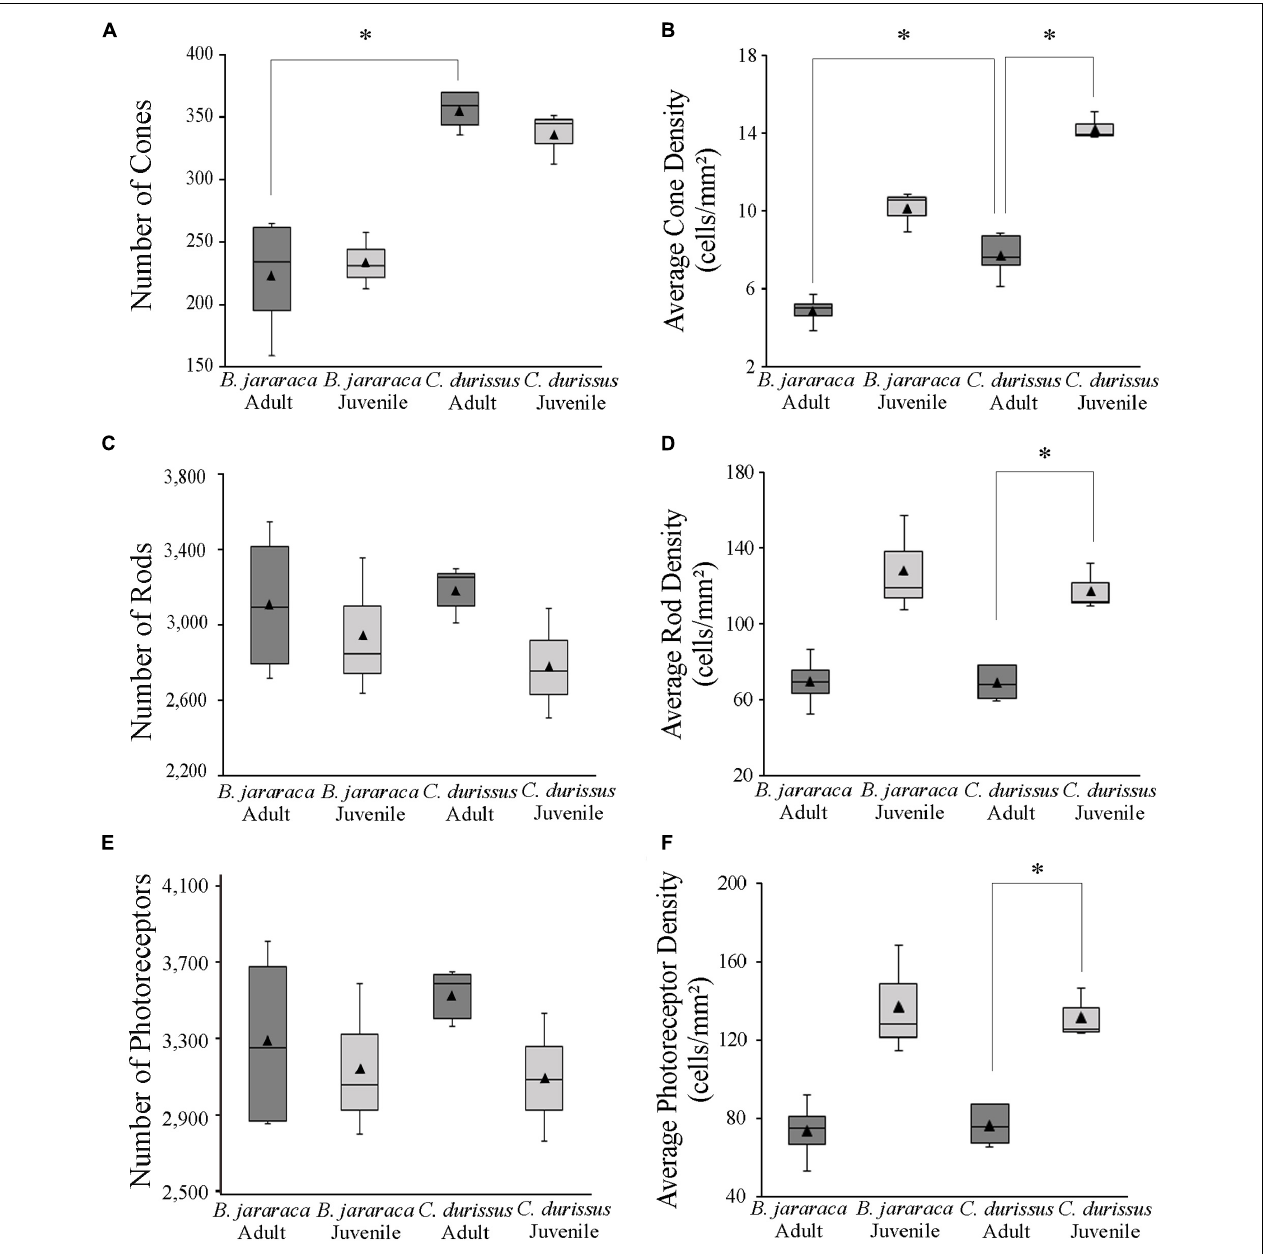
FIGURE 5 | Boxplot representations of the medians (thick black lines) and quartiles (boxes) of the total number and mean density of (A,B) cones, (C,D) rods, and (E,F) photoreceptors in retinas of adults and juveniles of B. jararaca and C. durissus . Mean density values are represented by the triangles. The values should be multiplied by 10 3 . Groups with statistically significant differences are indicated by asterisk ( ∗ p < 0.05).